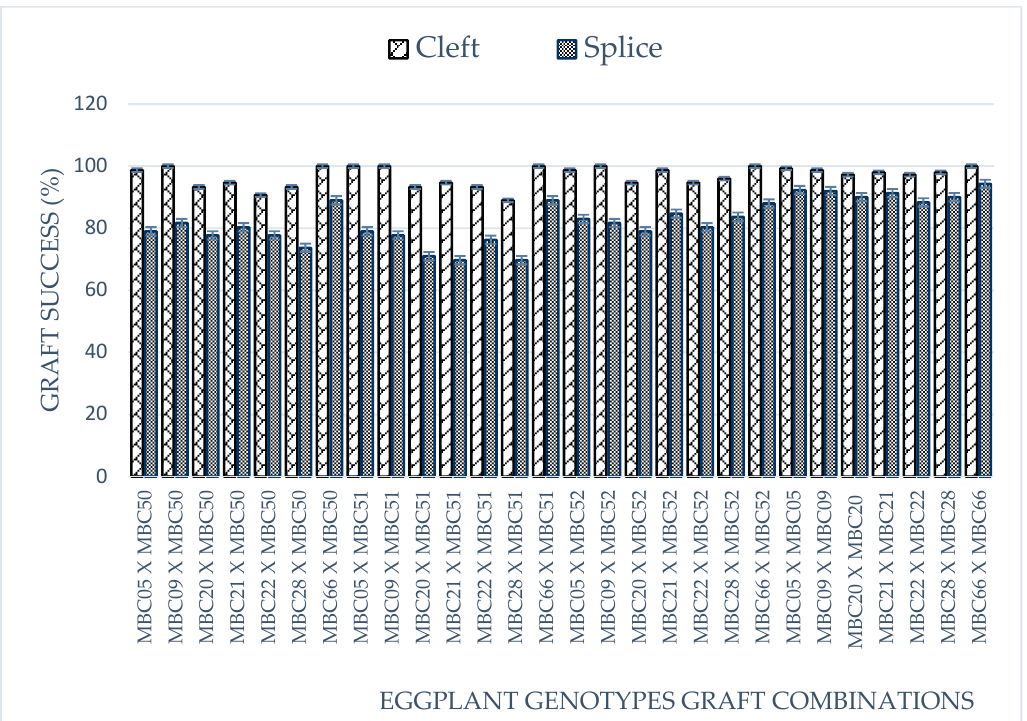
Figure 2. Percentage of graft success (%) with cleft and splice techniques, with significance level p = 0.05.